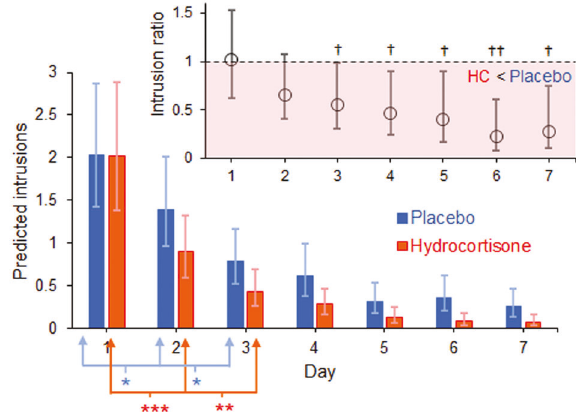
Fig. 2 Accelerated reduction in intrusive memories following hydrocortisone. Main panel: predicted mean (95% CIs) number of intrusions on days 1 – 7 in the placebo (blue bars) and hydrocortisone (red bars) groups. Signi fi cant sequential reductions between days for each drug (* p < 0.05; ** p < 0.01, *** p < 0.0001) are indicated. Inset: ratio of hydrocortisone intrusion counts relative to placebo, with values in the shaded region indicating lower hydrocortisone counts. Simulated ratios were skewed, accounting for the asym- metric 95% CIs. Upper bounds of 95% CIs do not cross 1 (dotted line) from day 3 onwards, indicating fewer intrusions in